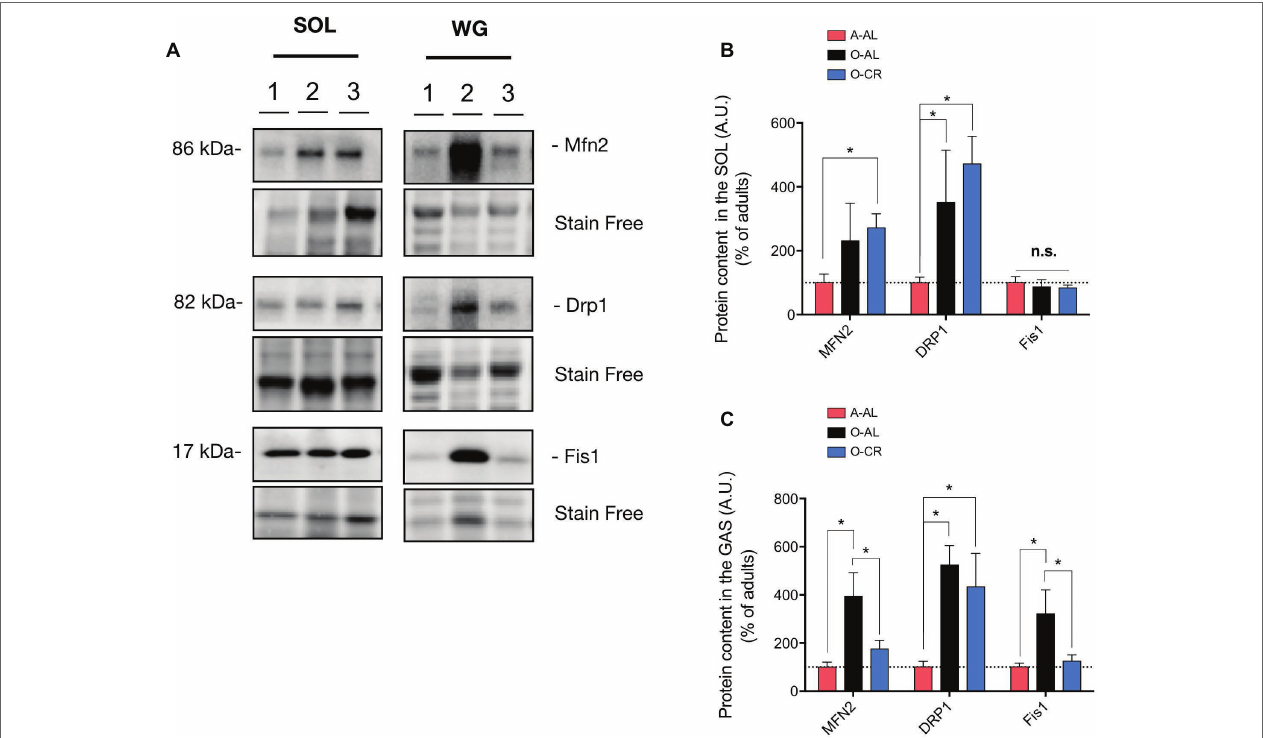
FIGURE 8 | Effect of skeletal muscle aging and caloric restriction on immunoreactive levels of proteins regulating mitochondrial dynamics in oxidative and glycolytic muscles. (A) Representative immunoblots of Mfn2, Drp1, Fis1 as well as their corresponding stain free images. (B,C) Quantification of Mfn2, Drp1, Fis1 proteins contents (normalized to their corresponding to their stain free intensity) in the SOL (B) and GAS (C) of adult (A-AL), old ad libitum-fed (O-AL) and old CR (O-CR) rats. Data in graphs are presented as Mean ± SEM ( n = 7–8 A-AL, n = 4 O-AL, n = 8–10 O-CR per group. * p <